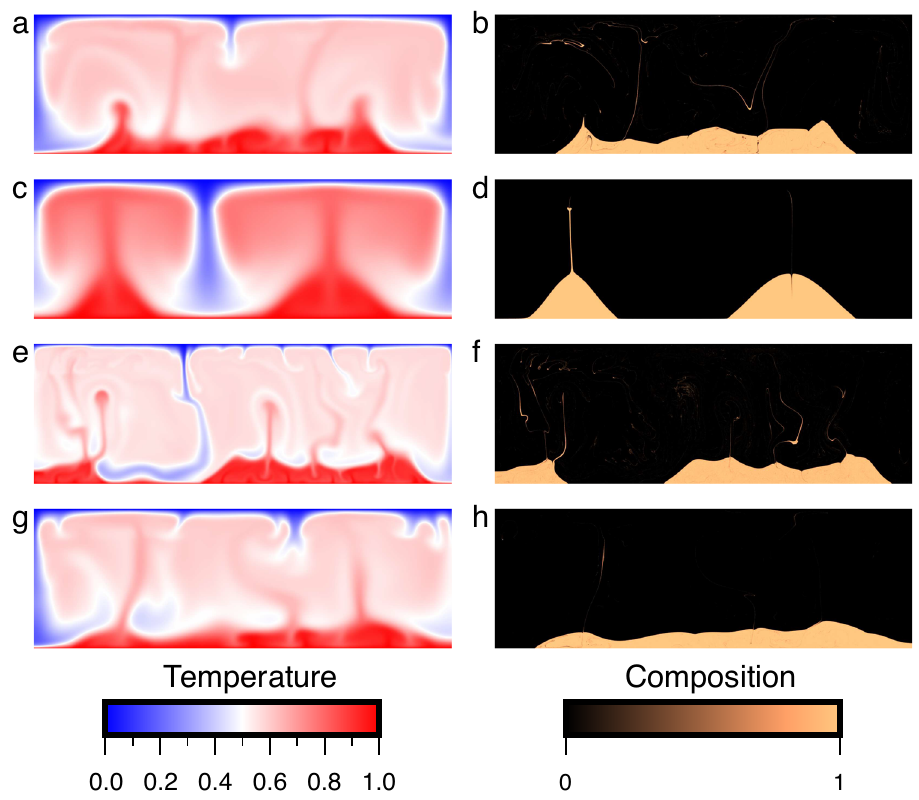
Fig. 5 Formation of thermochemical piles in the lowermost mantle from iron-rich materials. The temperature (left column) and composition (right column) fi elds from the surface to the core – mantle boundary are shown at 4.5 Gyr for case 1 ( a , b ), case 2 ( c , d ), case 3 ( e , f ), and case 4 ( g , h ). In cases 1, 2, 3, and 4, the Rayleigh number is Ra = 1 × 10 7 , 1 × 10 6 , 1 × 10 8 , and 1 × 10 7 , respectively, and the iron-rich materials (shown by golden colors in the right panels) are 1.2%, 1.2%, 1.2%, and 1.5% intrinsically denser than the background mantle materials (shown by black colors in the right panels), respectively. Large thermochemical piles form after 4.5 Gyr for all set as 70 Ry. The Mg pseudopotential was generated using the von Barth and Car method for all channels using a 2.5 Bohr cutoff radius and fi ve con fi gurations, Martins method 63 with the cutoff radius of 1.47Bohr for Si and 1.45Bohr for O. Valence con fi gurations for Si and O are 3s 2 3p 4 3d 0 and 2s 2 2p 4 , respectively. The pseudopotentials for Al and Fe were generated using the Vanderbilt method 64 with a valence con fi guration of 3s 2 3p 1 and a cutoff radius of 1.77 Bohr for Al, and a valence con fi guration of 3s 2 3p 6 3d 6.5 4s 1 4p 0 and a cutoff radius of 1.8Bohr for Fe. To address the large on-site Coulomb interactions among the localized electrons